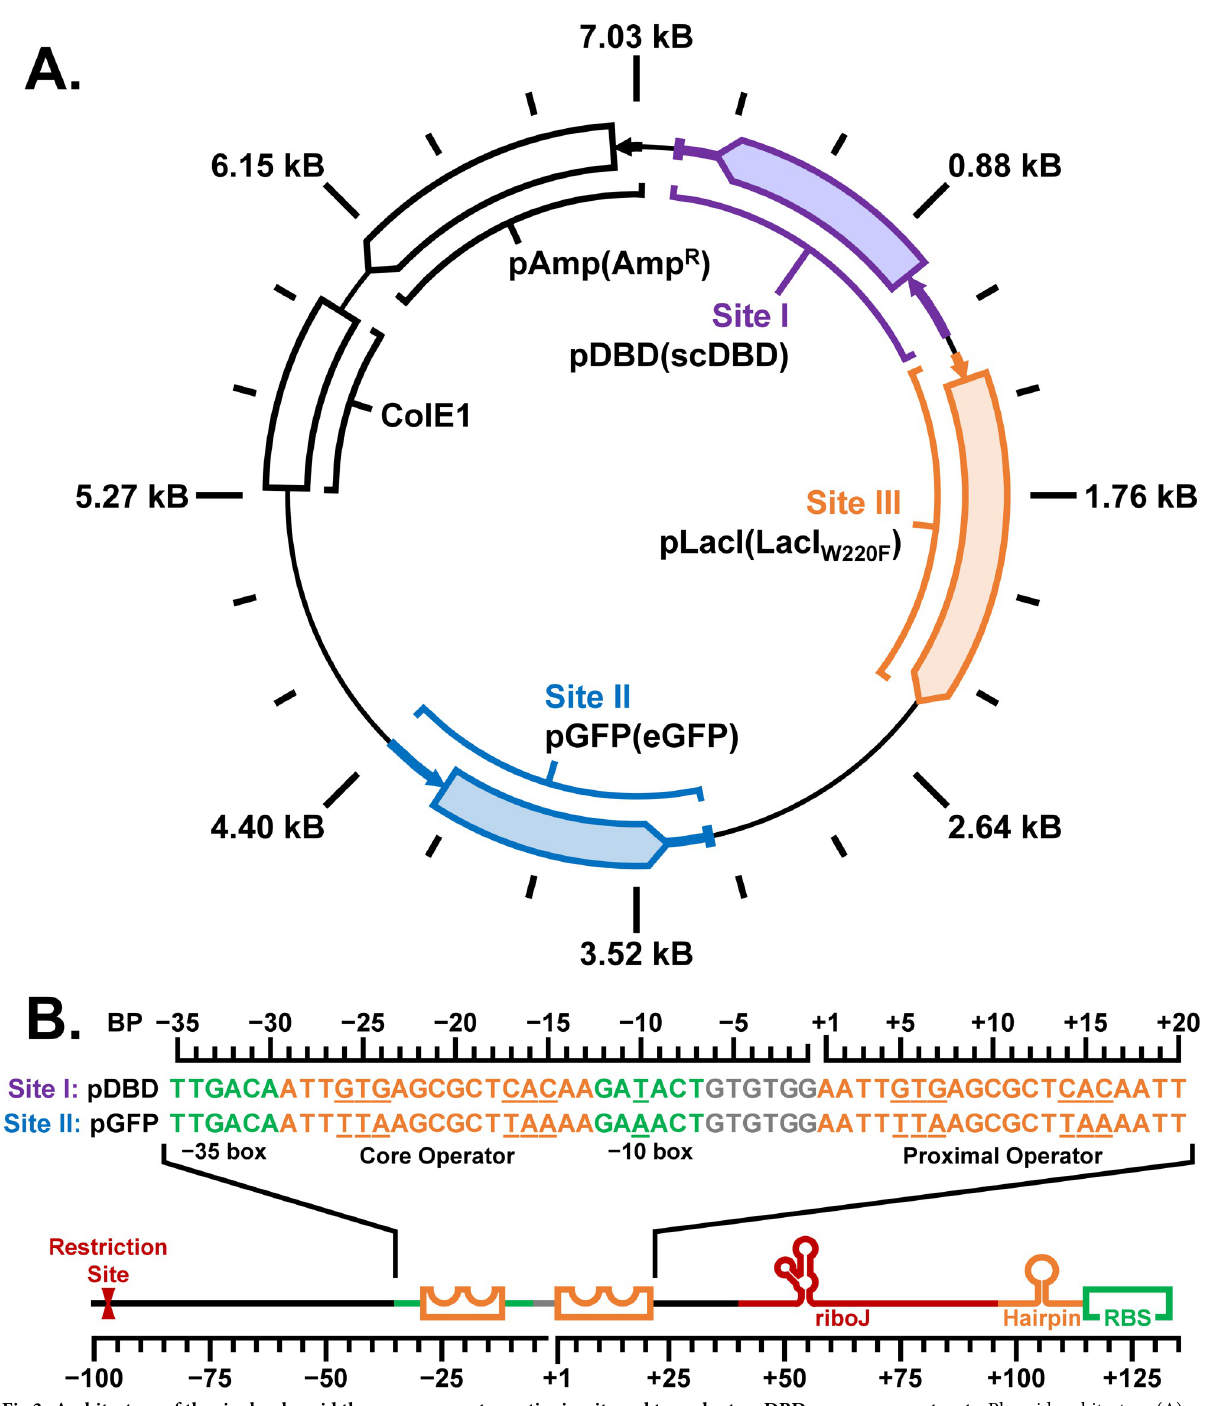
Fig 3. Architecture of the single-plasmid three-component genetic circuit used to evaluate scDBD repressor constructs. Plasmid architecture (A) includes the ColE1 origin and ampicillin resistance selection marker (Amp R ) in addition to the three genetic circuit components: pDBD(scDBD), pGFP (eGFP), and pLacI(LacIW220F), incorporated at Cloning Sites I, II, and III, respectively. The gene cassettes of Site I (scDBD) and Site II (eGFP) are flanked by identical T7 terminator sequences and near identical pDBD and pGFP promoter sequences, respectively. The promoter regions (B) of Cloning Sites I and II deliver identical riboJ genetic insulator, hairpin, and ribosome binding site (RBS) sequences upstream of the start codon. These promoter cassettes differ by the identity of their − 10 box promoter sequence and their operator sequences placed at positions core and proximal along the cassette, with base pair (BP) position indicated relative to the mRNA transcription start site. The operator elements belonging to the pDBD promoter (Site I) incorporate the lacO sym operator sequence responsible for recruiting the LacI W220F repressor expressed by the pLacI promoter from